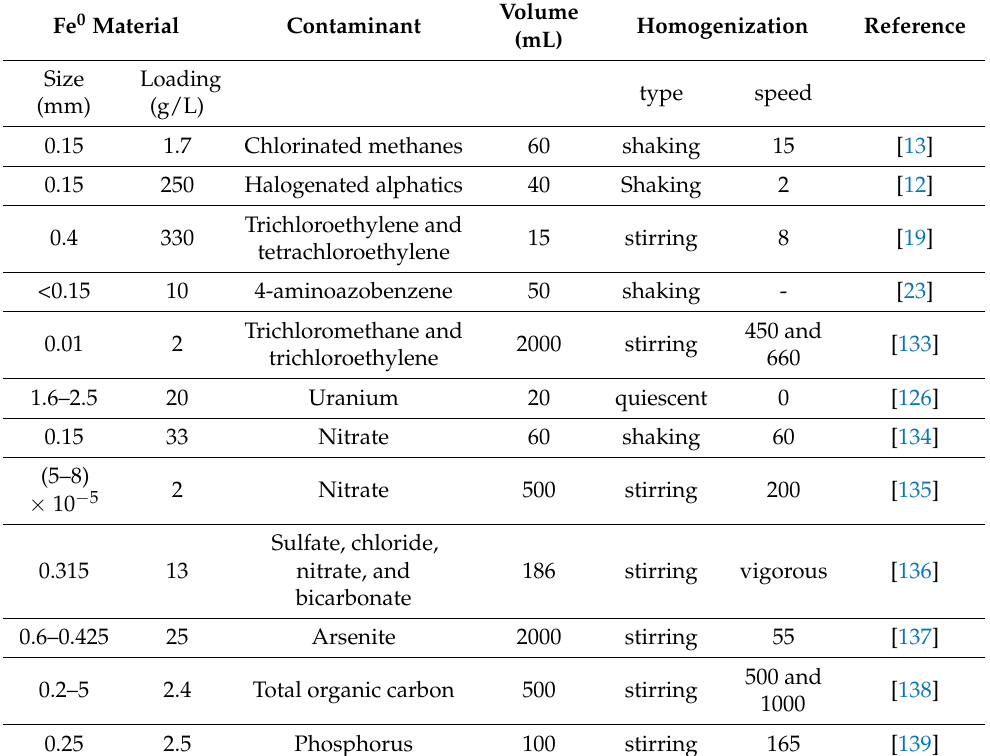
Table 4. Experimental conditions of some selected studies investigating the operating mode of the Fe 0 /H 2 O system in batch mode. It is seen that in the initial phase (here up to 1998) only low homogenization intensities were used; such conditions are representative of field